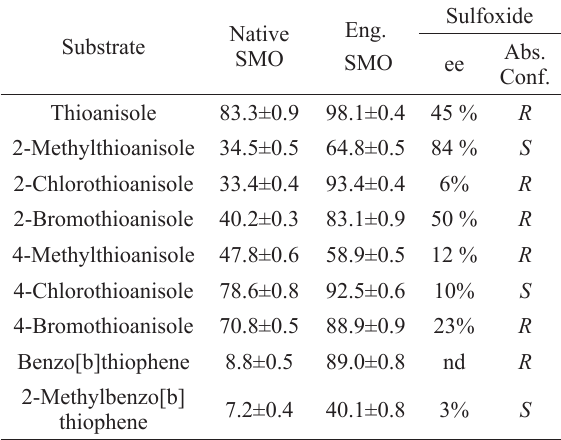
when compared to the well-accepted substrates, suggested that geometric and/or electrostatic features of the enzymes are involved in the regio- and stereo-specificities of the reaction. In another report, the proposed model for the active site of cyclohexanone monooxygenase is described as having three hydrophobic pockets: the main pocket (M) as well as a small (H ) and a large (H ) pocket, S L Figure 4. In this model, the circled area locates the position of sulfur (or S = O for products) in the molecule. Even though the small pocket has a hydrophobic character, it is also known that H is S probably the natural pocket for hydroxyl group in Baeyer-Villiger oxidation of cyclic ketones. This suggests the existence of a polar-site directing the substrate orientation. For this reason an increase in hydrophobicity in this site decreases the ee (from 99% to 12%) (Ottolina et al. 1995), Figure 9.